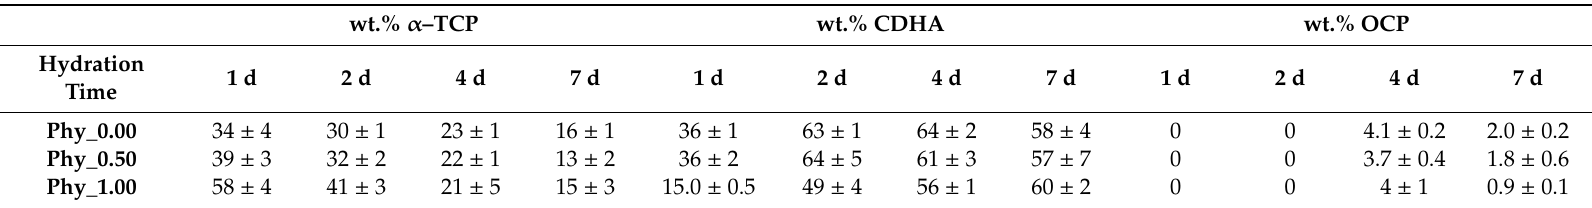
Table 4. The quantitative phase composition of samples composed of α –TCP and CDHA (weight ratio 9:1) with different amounts of sodium phytate after 1 d, 2 d, 4 d and 7 d of hydration; a 0.2 M Na 2 HPO 4 aqueous solution was used as the mixing liquid with an L / P of 0.3 ml / g Powder ; the samples were stored at 23 ◦ C.